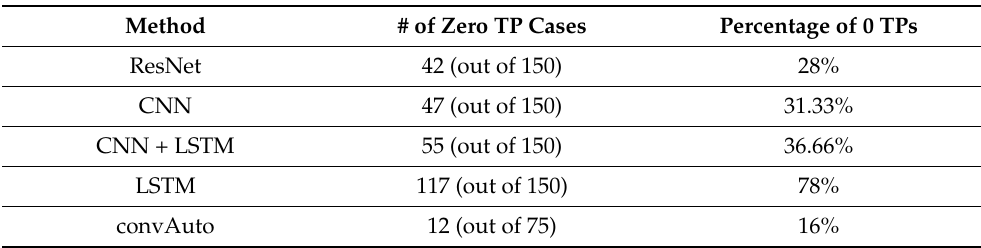
Table 1. The misclassification rate of Intermediate users with each method, as shown by the Interme- diate True Positive (TP)